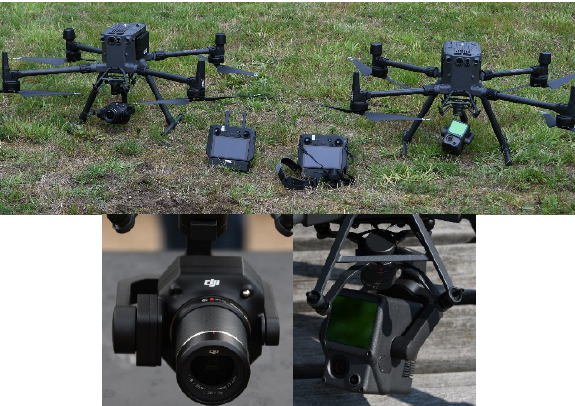
Figure 2: Top - DJI Matrice 300 RTK with Zenmuse P1 camera (left) and L1 laser scanner (right), bottom - Zenmuse P1 camera (left) and L1 laser scanner (right).